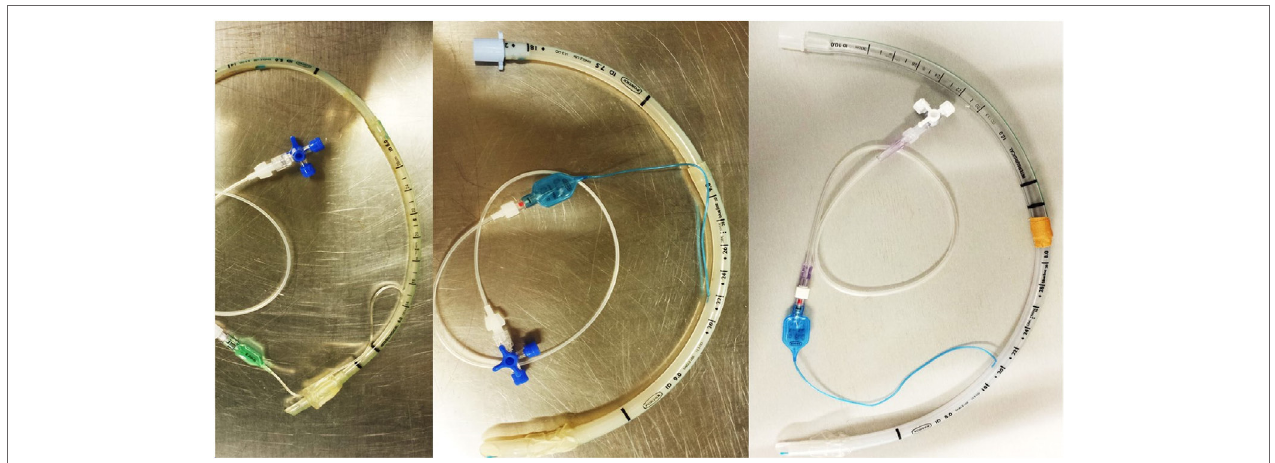
FIGURe 1 | Three pairs of endotracheal tubes connected end to end were prepared on the day before surgery: tubes of 5.0-mm internal diameter (ID) with 6.0-mm ID, 7.5-mm ID with 9.0-mm ID, and 8.0-mm ID with 10-mm ID. The proximal connector of the more distal tube of each pair was removed and attached with adhesive tape to the distal extremity of the more proximal tube. The balloon cuff of the more proximal tube was removed, while the balloon cuff of the more distal tube was connected to a tubing extension and a three-way stopcock that was maintained outside the animal’s mouth. It could have been used to pull out the distal tube in case of